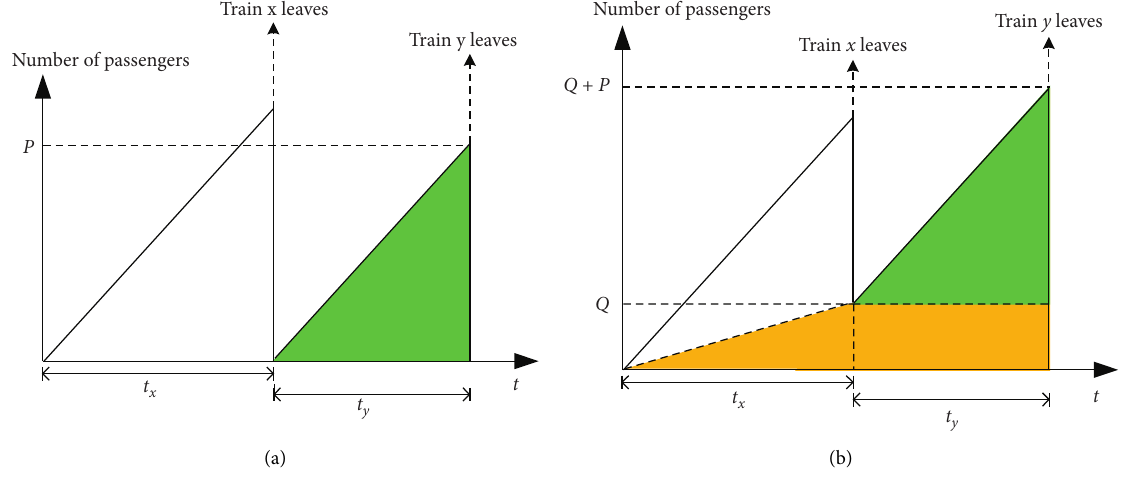
Figure 7: Relation between passenger number and time at